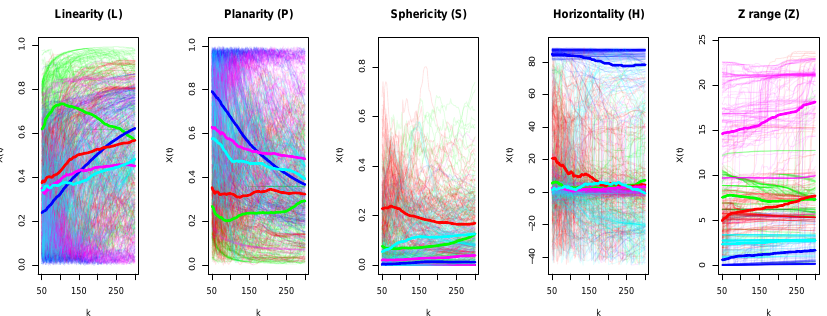
Figure 9. A sample of n = 150 curves representing the features measured on K = 100 scales. Each color represents a label or type of object: poles (green), ground (blue), vegetation (red), buildings (magenta), and vehicles (cyan). Mean values for each class are represented as wider